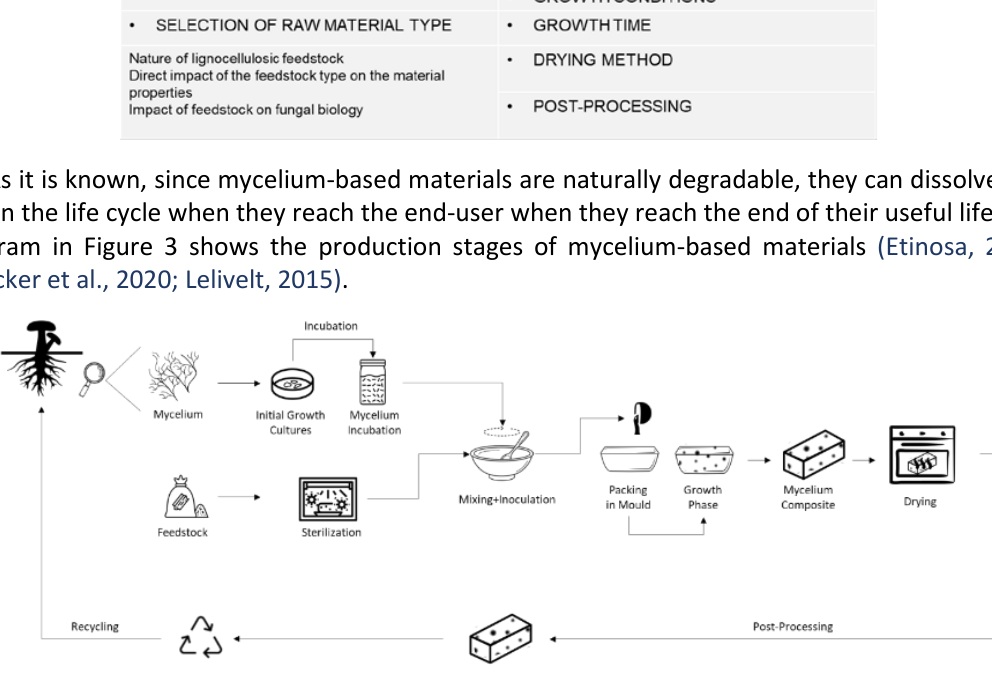
Figure 3 Diagram Showing the Production Stages of Mycelium-Based Materials (adopted Dias et al., 2021; Elsacker et al., 2020; Girometta et al., 2019; Lelivelt, 2015; Rafiee et al., 2021; Udayanga, D., & Miriyagalla,